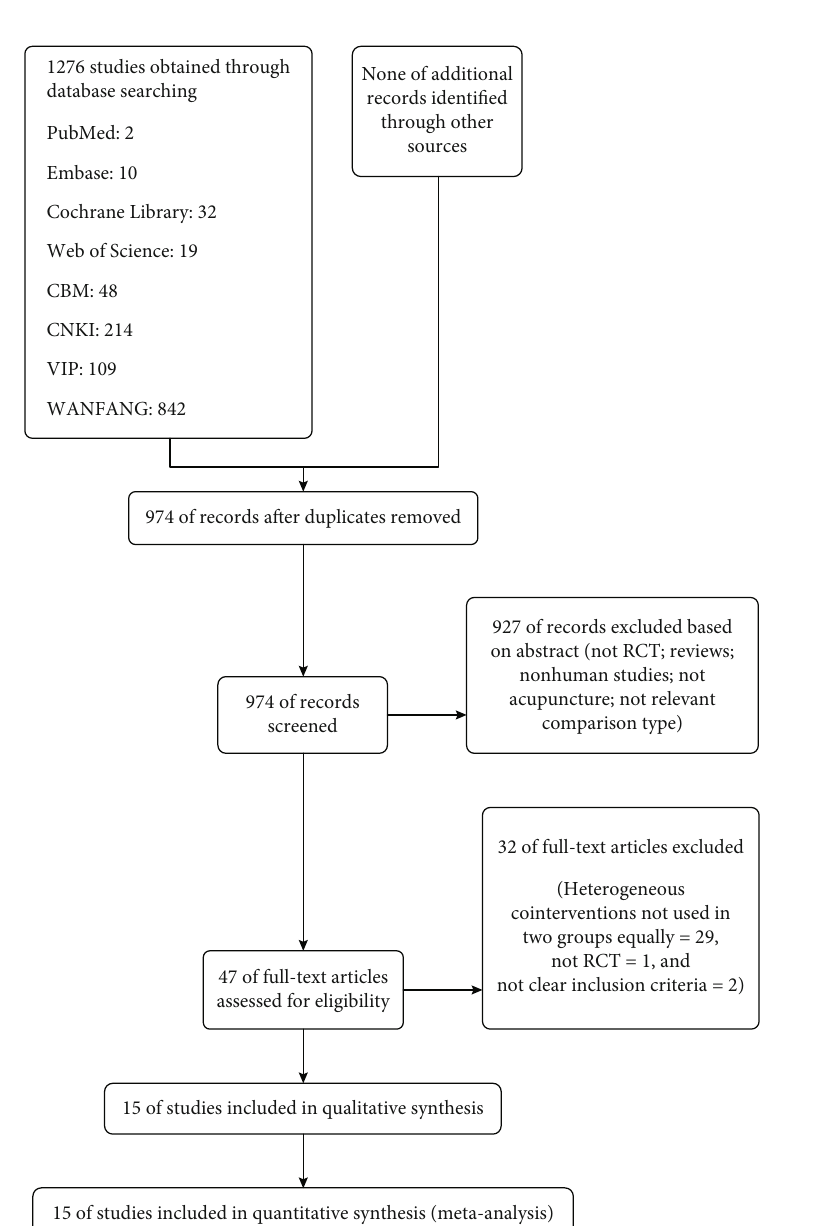
Figure 1: Flowchart of study